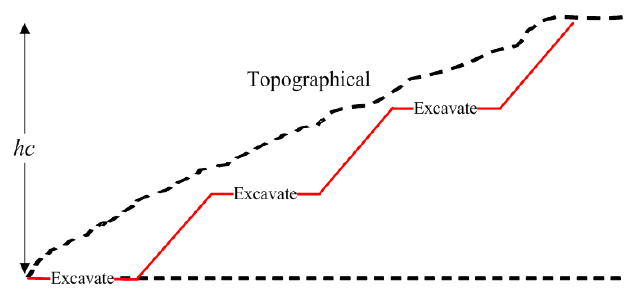
Figure 2. Schematic diagram for excavation slope of portal section.